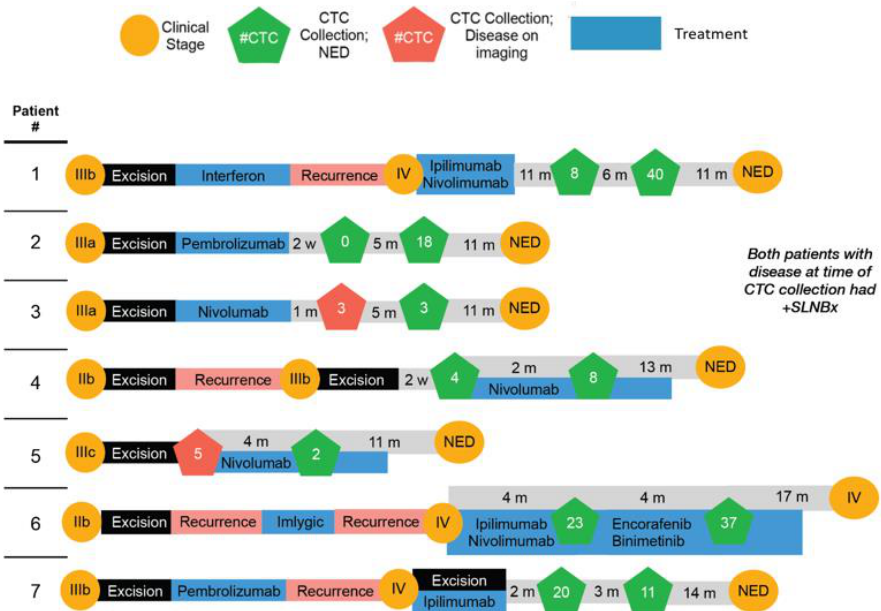
Figure 4. Timelines of CTC Collection. This illustration demonstrates collection times and the number of CTCs collected with accompanying clinical data including disease stage (yellow circles), surgical excisions (black rectangles), treatments (blue rectangles), and disease recurrence (pink rectangles.) Green pentagons indicate CTC collections taken at a time when patients had no clinical evidence of disease through diagnostic imaging. Red pentagons indicate CTC collections taken when patients had evidence of disease, such as a positive sentinel lymph node biopsy. NED; no evidence of disease. SLNBx; sentinel lymph node biopsy.